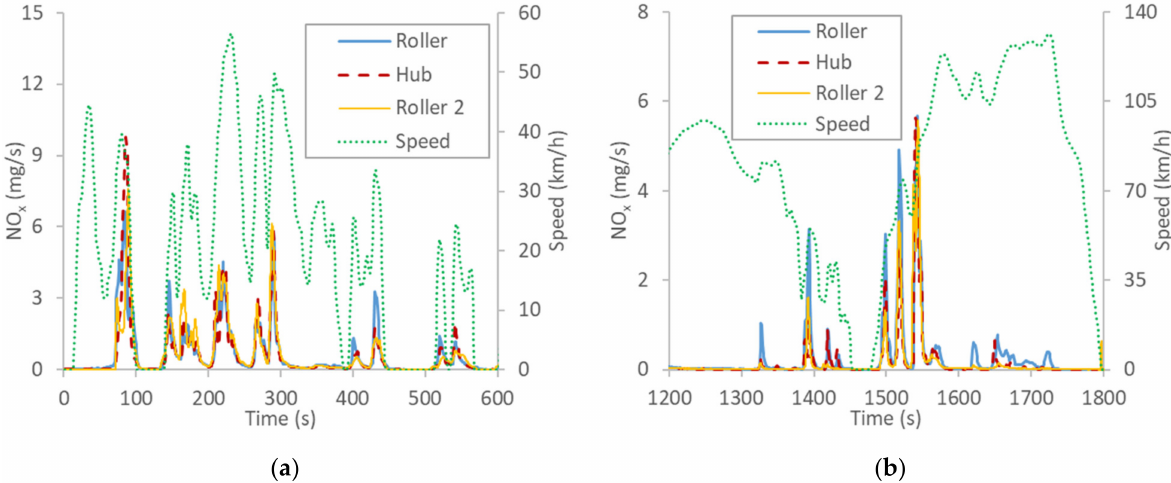
Figure 3. Real-time emissions of NO x : ( a ) cold-start urban (low) part of WLTC; ( b ) motorway (high and extra high) part of